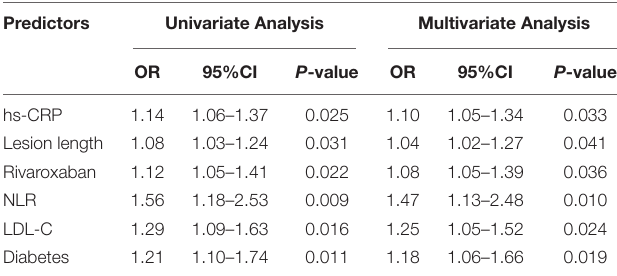
TABLE 4 | Predictive factors for 1-year restenosis after DCB for femoropopliteal artery